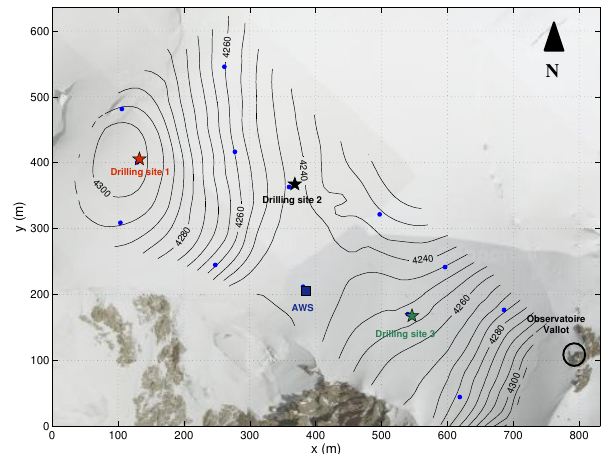
Fig. 1. Map of Col du Dôme (Mt Blanc range, France) showing the locations of the automatic weather station (AWS; blue square), density measurement sites (blue dots) and borehole drilling sites